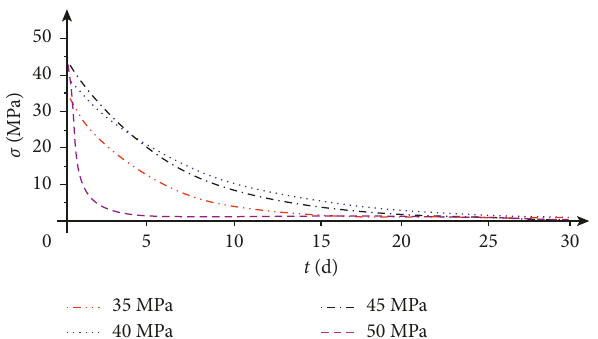
Figure 8: The change curve of the permeability coefficient with strain.